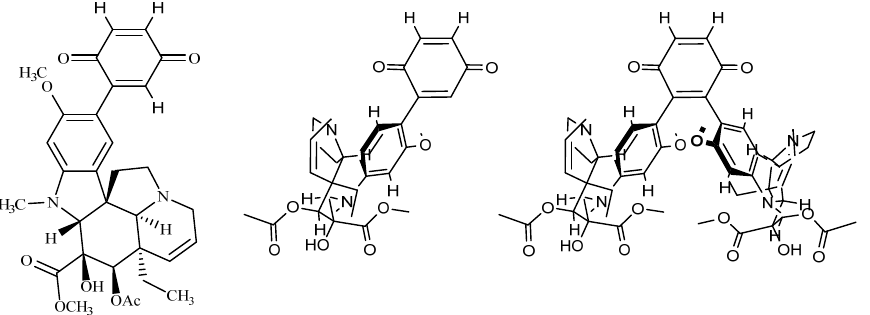
Figure A1. Two representations of mono adduct 3 and of di-adduct 6a1 .